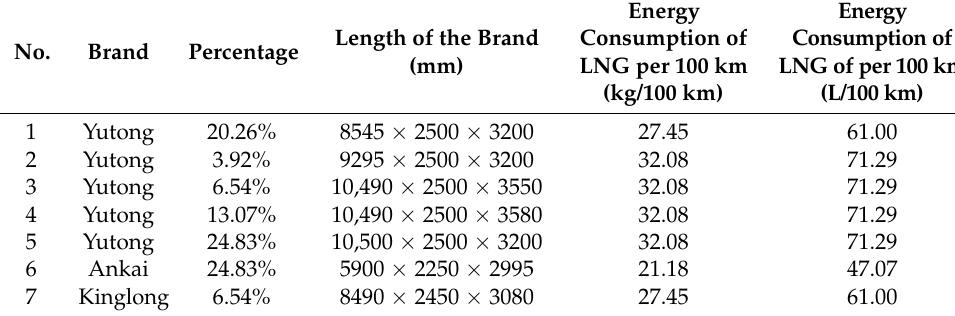
Table 8. Energy consumption of natural gas for different brands of